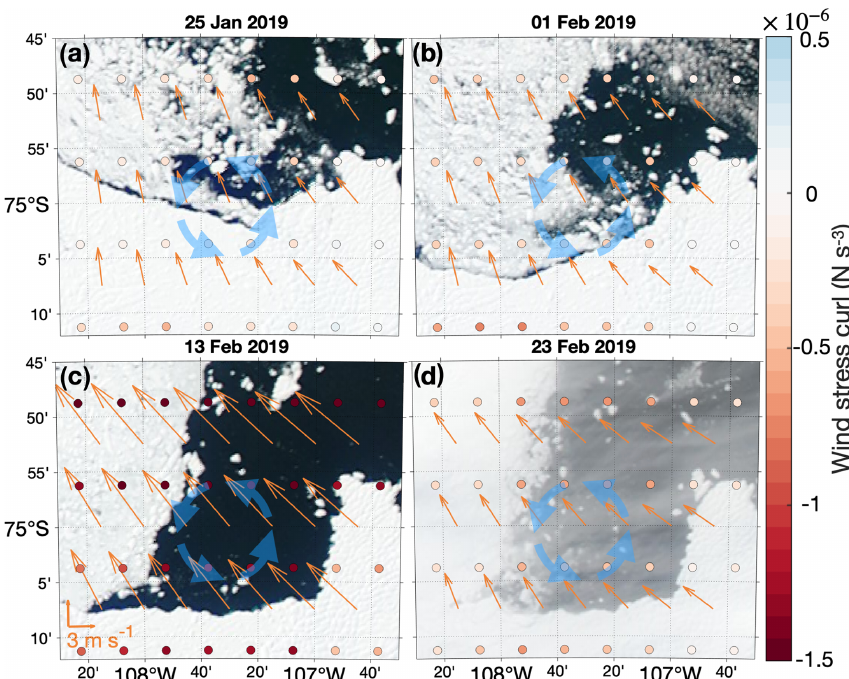
Figure 4. The ice conditions in the Thwaites gyre region. The orange arrows denote daily-averaged wind speed from the ERA5 reanalysis (Hersbach et al., 2018) (0 . 25 ◦ × 0 . 25 ◦ resolution; for clarity, velocity data are meridionally interpolated to 0 . 25 ◦ × 0 . 125 ◦ resolution). Dots are coloured by the wind stress curl calculated from the interpolated 0 . 25 ◦ × 0 . 125 ◦ resolution daily-averaged wind speed from the ERA5 reanalysis (Hersbach et al., 2018). Thick blue arrows indicate the Thwaites gyre. Ice imagery is from (a) 25 January, (b) 1 February, (c) 13 February and (d) 23 February 2019, respectively, as stated above each panel.